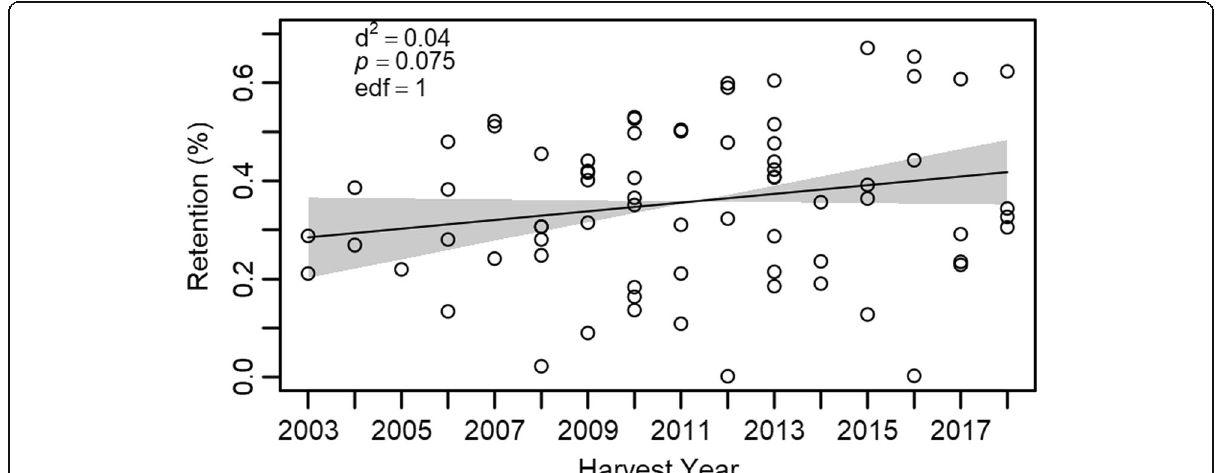
Fig. 4 Generalized additive model of the relationship between harvest year and retention level for coupes with retention > 0 ( n = 73). The model has simplified to a linear model (edf = 1), but the relationship is not significant ( p = 0.075). Shaded areas indicate the 95% confidence interval. d 2 is the proportion of the null deviance explained by the model. p values indicate the approximate significance of the single smooth term, while edf is the estimated degrees of freedom for the smooth term